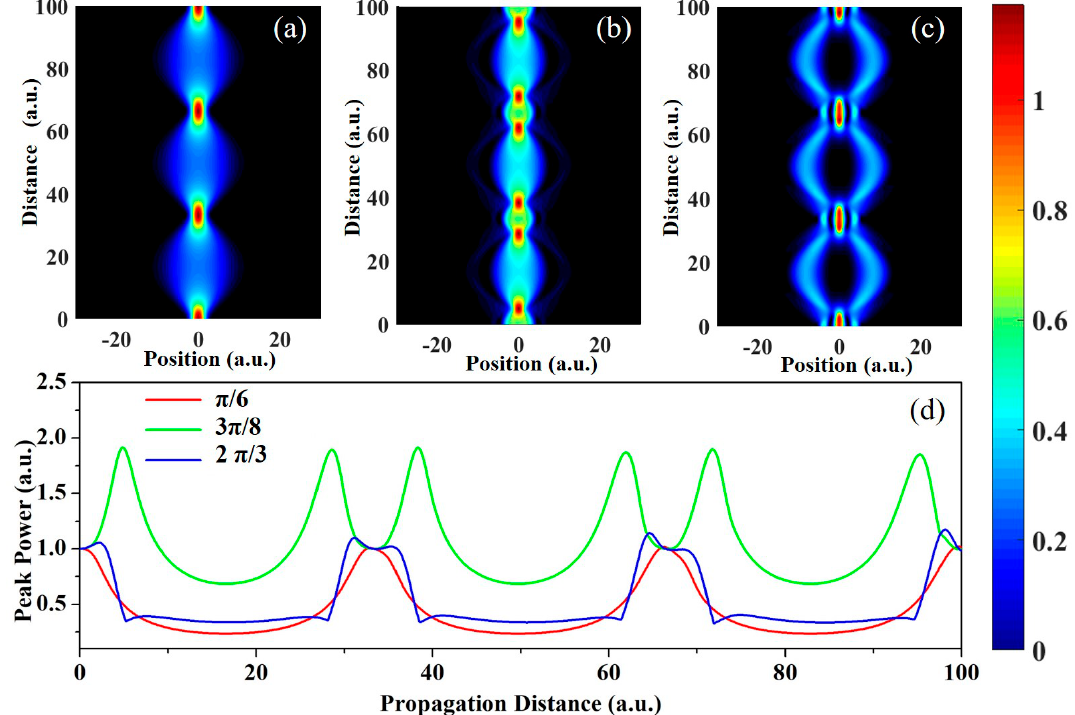
Figure 2. When x 0 = 1, P 0 = 10, ω 0 = 0.03, the spatial evolutions of Cos − Gaussian pulses with three different initial phases: ( a ) φ 0 = π /6, ( b ) φ 0 = 3 π /8, and ( c ) φ 0 = 2 π /3; ( d ) the peak power evolution of different initial phases: ( a ) ϕ 0 = π /6, ( b ) ϕ 0 = 3 π /8, and ( c ) ϕ 0 = 2 π /3; ( d ) the peak power evolution the breathing solitons: φ 0 = π /6 (red line), φ 0 = 3 π /8 (green line), and φ 0 = 2 π /3 (blue line). of the breathing solitons: ϕ 0 = π /6 (red line), ϕ 0 = 3 π /8 (green line), and ϕ 0 = 2 π /3 (blue